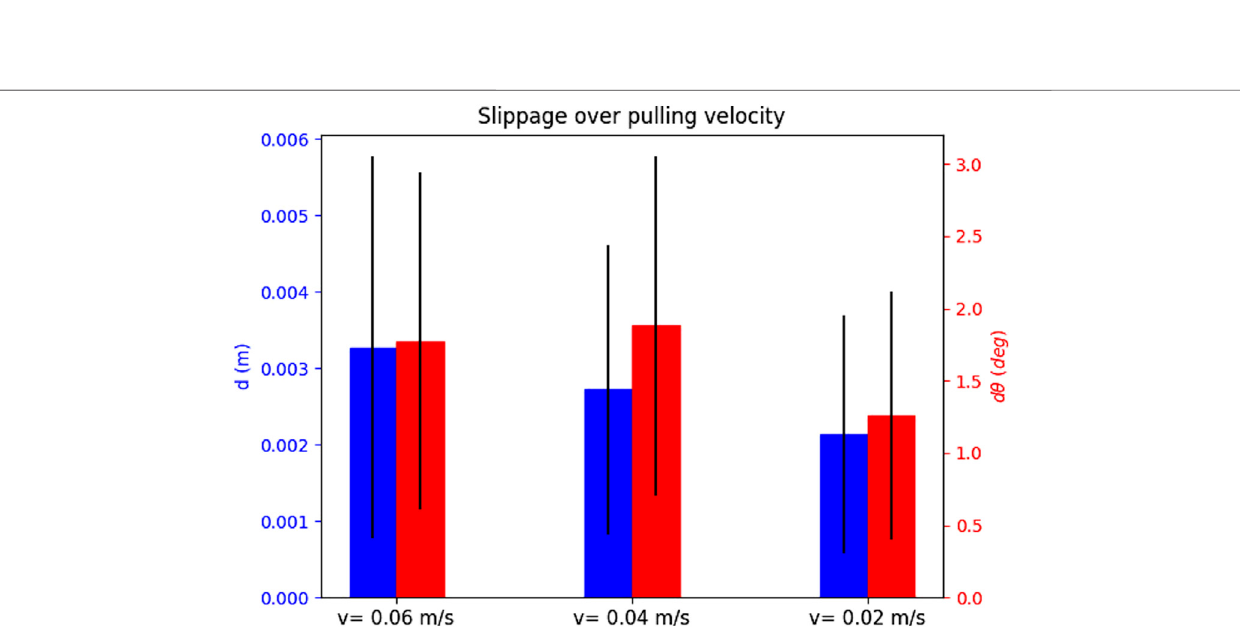
FIGURE 9 | The effect of the pulling pro fi le on grasp stability for the simulation